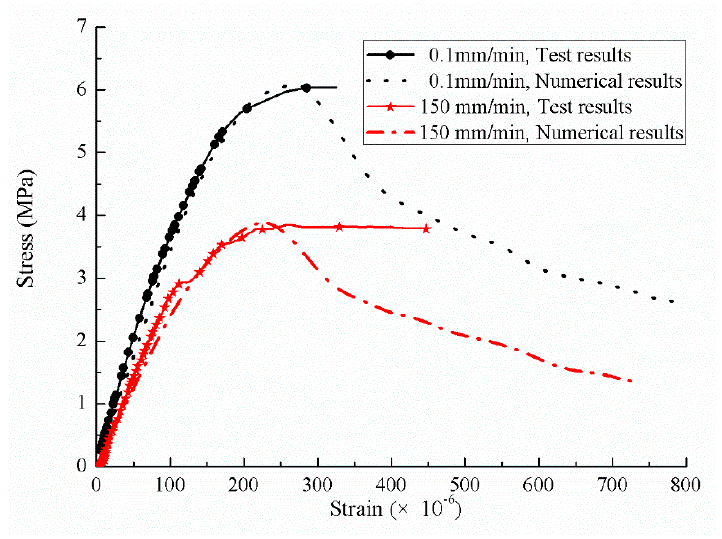
Figure 18. Stress-strain curves comparison under different loading rates.